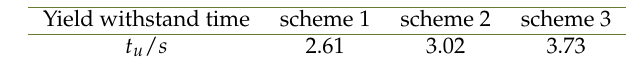
Table 8. Yield seismic resistance time of